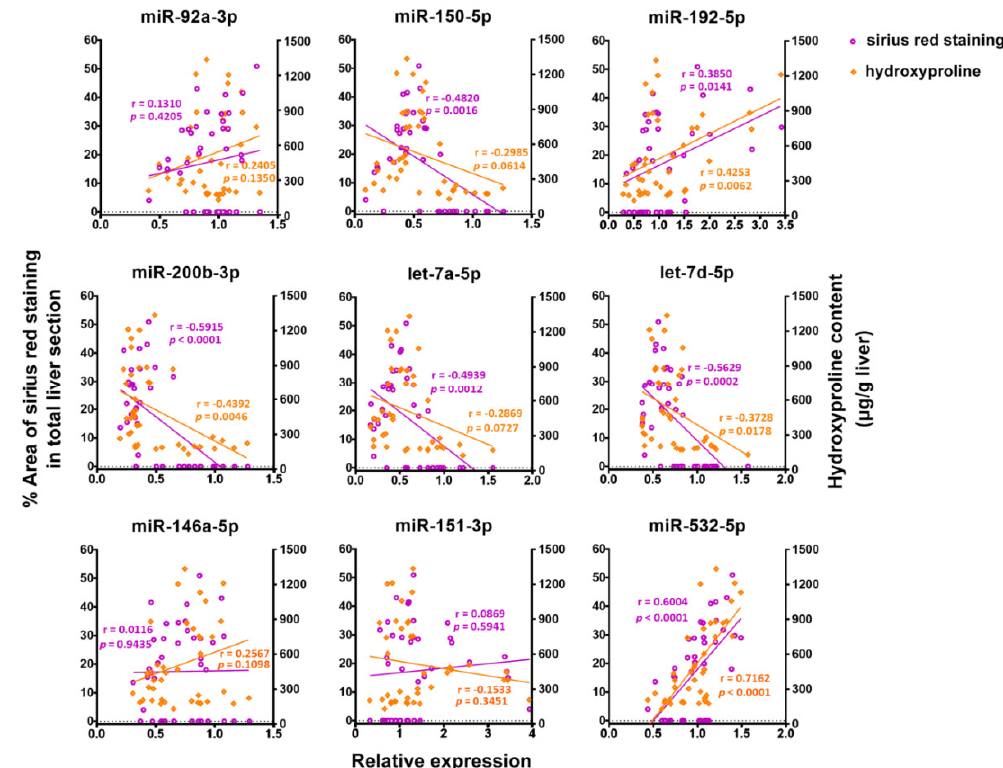
Figure 3. Correlations of serum levels of nine exomiRs with the intensities of liver fibrosis determined by sirius red staining and with liver hydroxyproline content in C57BL/6 mice during S. japonicum infection (Pearson’s r ).